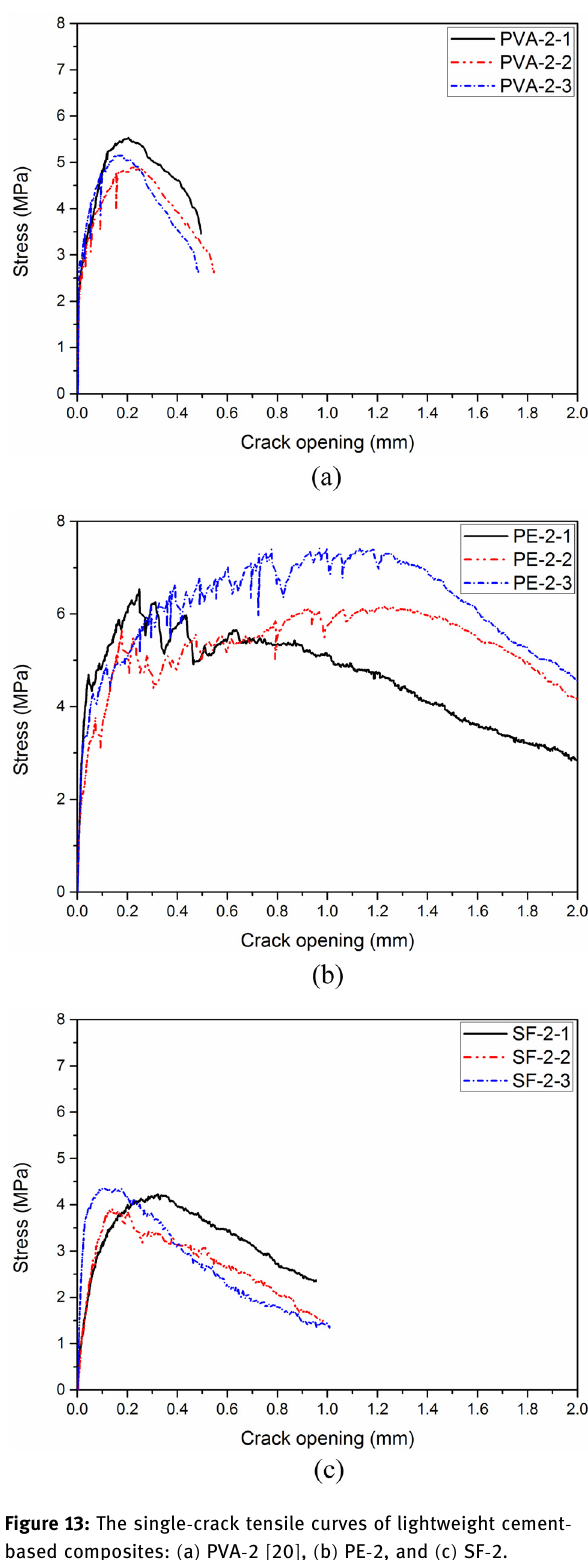
Figure 13: The single - crack tensile curves of lightweight cement - based composites: ( a ) PVA - 2 [ 20 ] , ( b ) PE - 2, and ( c ) SF -